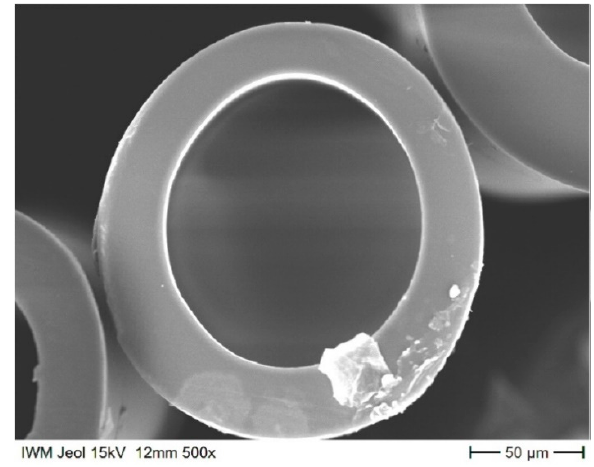
Figure 1. Laboratory-scale melt spinning setup and sketch of the 4-hole spin plate: ( a ) hopper; ( b ) extruder; ( c ) spin head; ( d ) godet duo; ( e ) winder; ( f ) 4-hole core–shell spin plate with supporting air in the core.